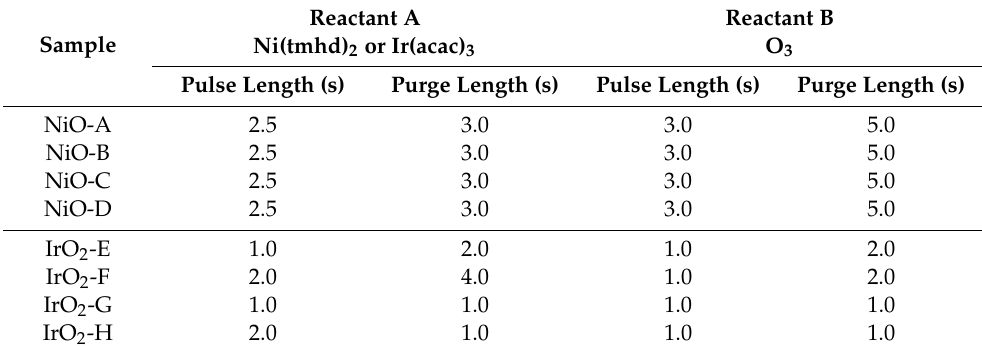
Table 3. Precursors pulse and purge length of the electrode materials.